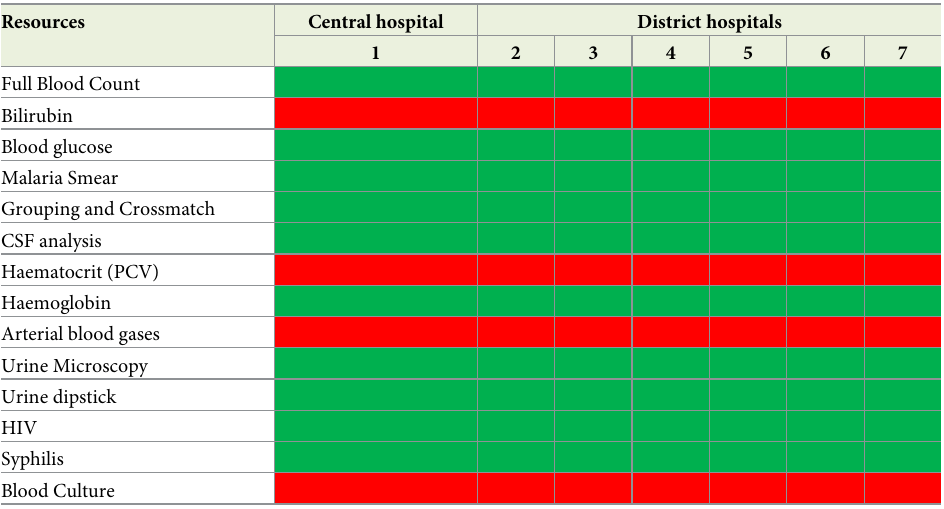
Table 4. Laboratory 1